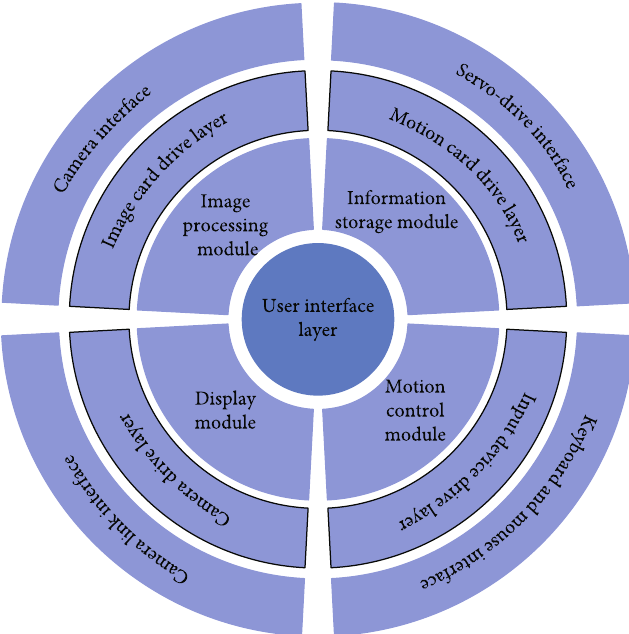
Figure 3: The software hierarchy of the control